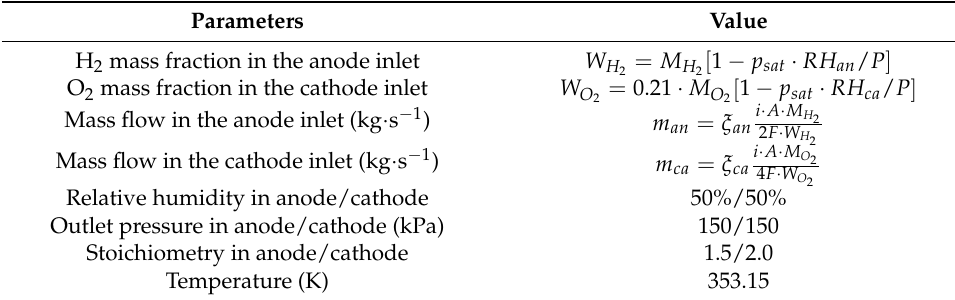
Table 3. Boundary